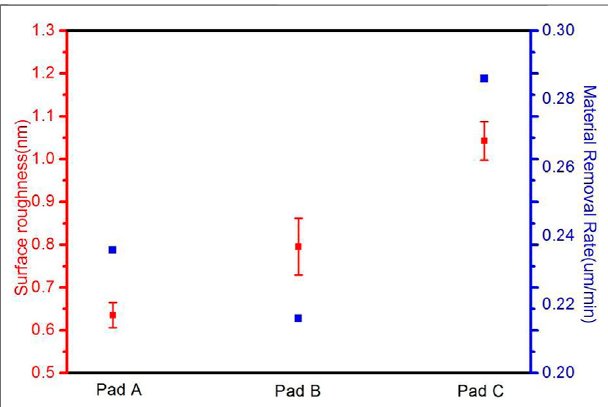
FIGURE 1 | RMS roughness and MRR of GaSb wafers for the three